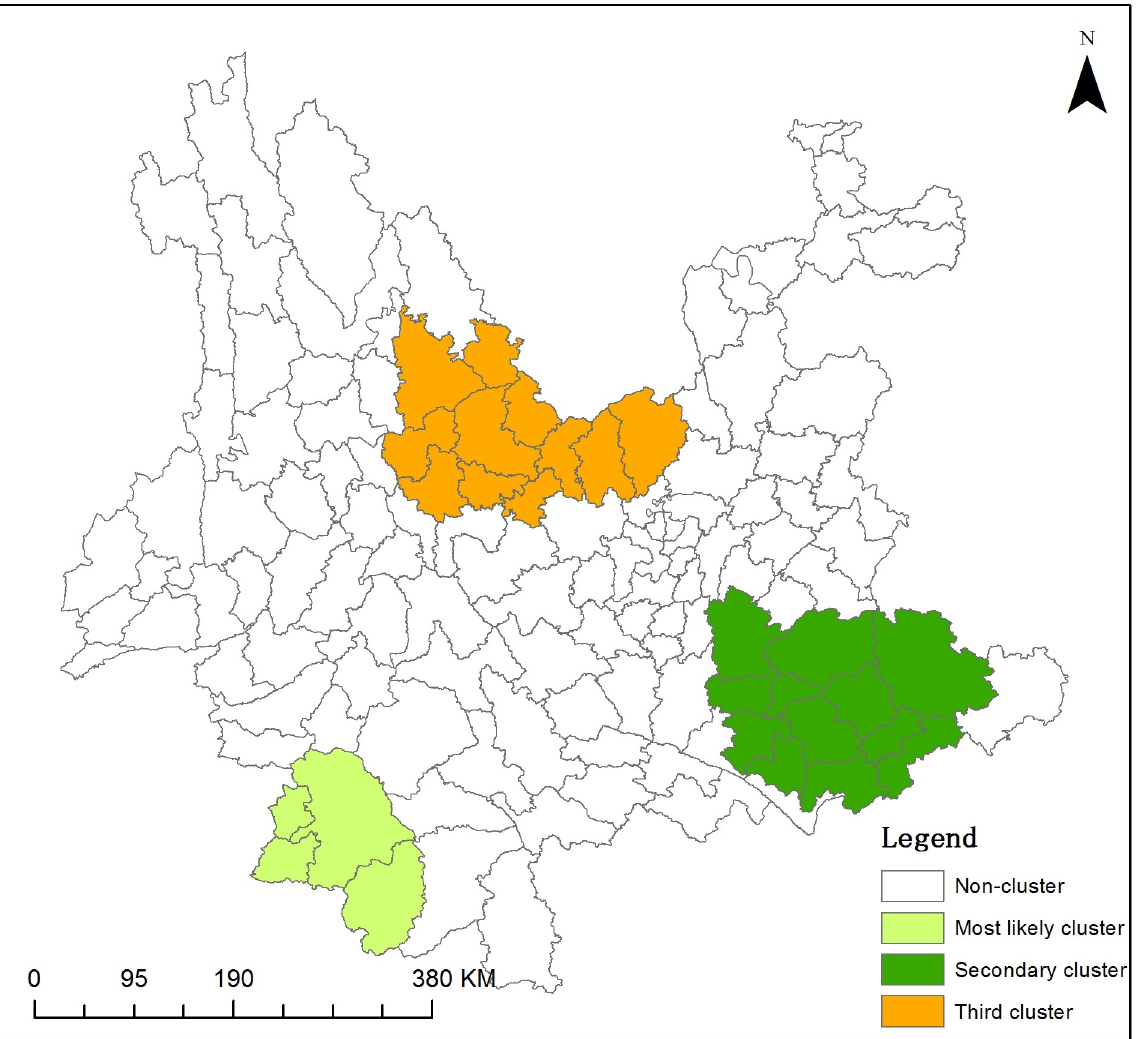
Fig 4. Spatiotemporal Clusters of Newly Detected Leprosy Cases in Yunnan, China, 2011–2020. The base layer is from